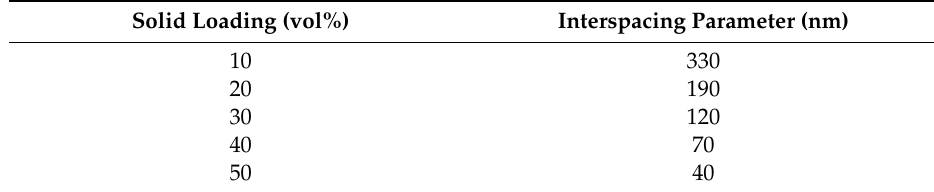
Table 4. Interspacing parameter values in function of solid loadings.